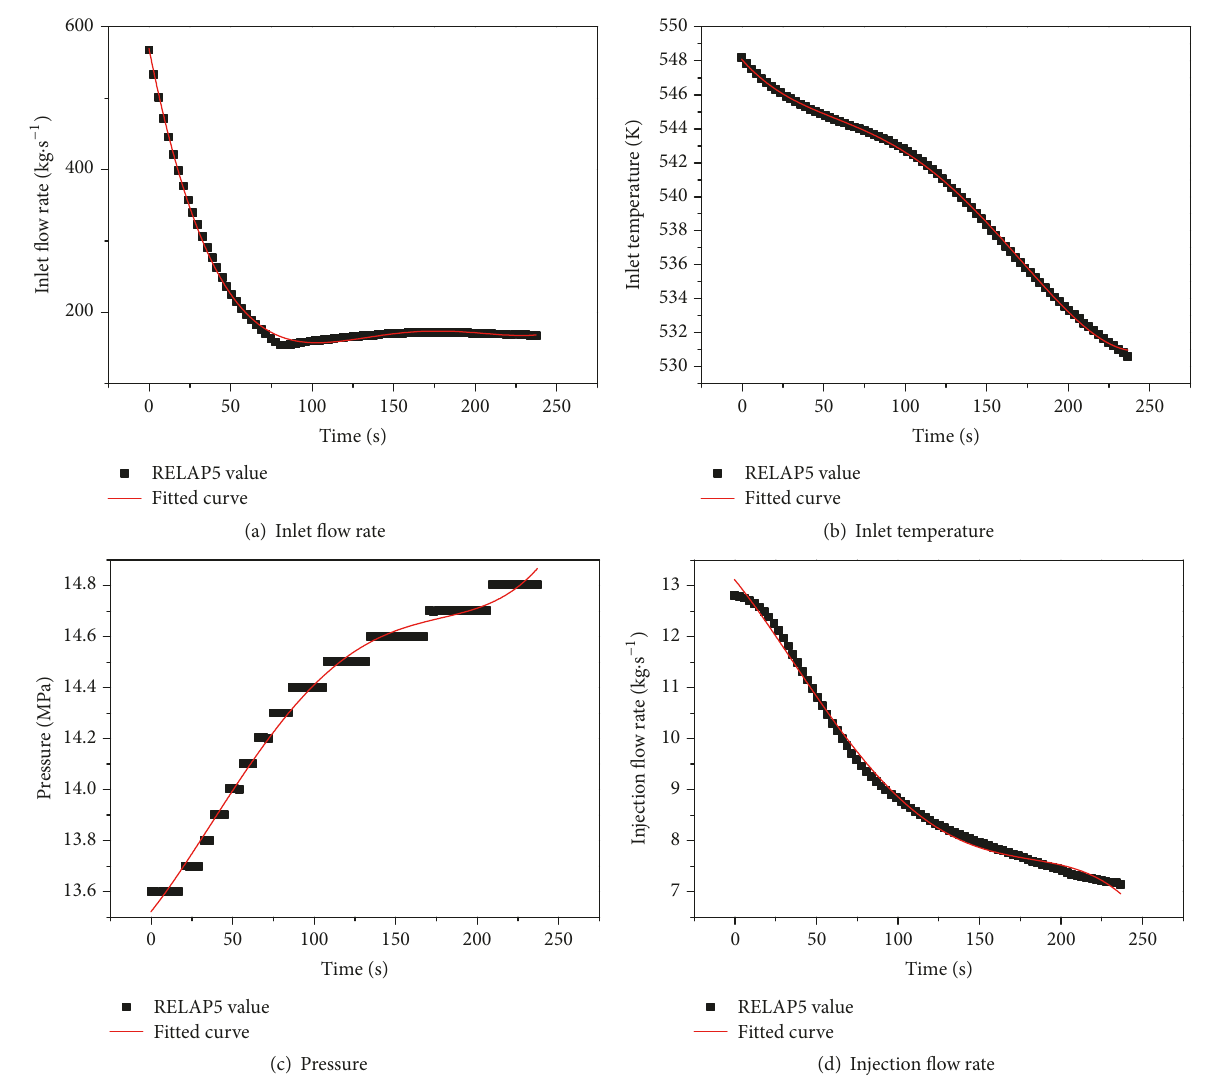
Figure 12: Fitted boundary conditions from 150 s to